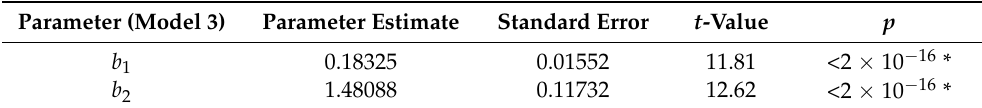
Table 6. Results of the GLS regression Model 3 on the test data.